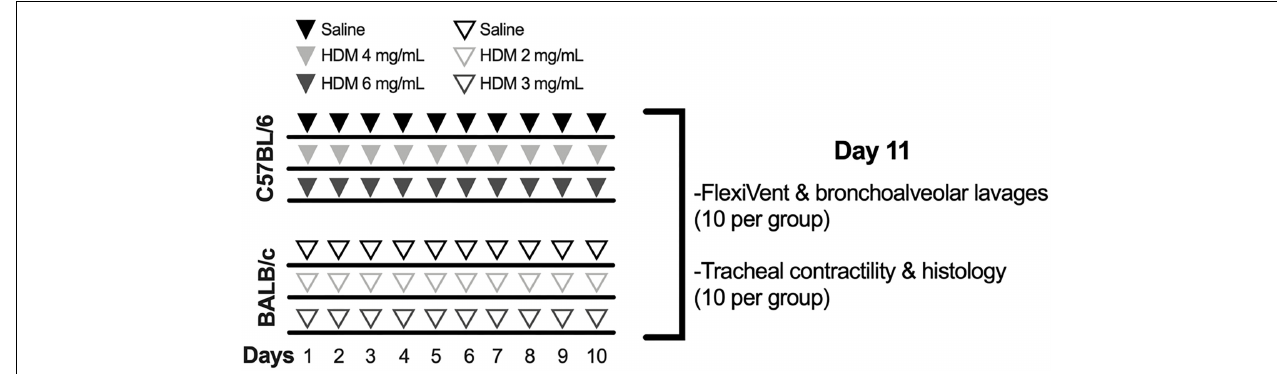
FIGURE 1 | Experimental protocol to induce pulmonary allergic inflammation. While 60 C57BL/6 mice were exposed to saline ( n = 20) or either 4 ( n = 20) or 6 mg/mL ( n = 20) of house dust mite (HDM), 60 BALB/c mice were exposed to saline ( n = 20) or either 2 ( n = 20) or 3 mg/mL ( n = 20) of HDM once daily for 10 consecutive days. At day 11, the degree of in vivo airway responsiveness to methacholine was measured in half of the mice within each group ( n = 10) using the flexiVent. The same mice were used to collect the bronchoalveolar lavages in order to measure cellular inflammation. The trachea was collected in the other half of mice within each group ( n = 10), also at day 11, in order to measure the contractile capacity of airway smooth muscle in response to incremental concentrations of methacholine and potassium chloride. The left lung of the same mice was collected and processed for histology to quantify the infiltration of inflammatory cells within the tissue, the content of airway smooth muscle, the number of goblet cells and the thickness of the epithelium.